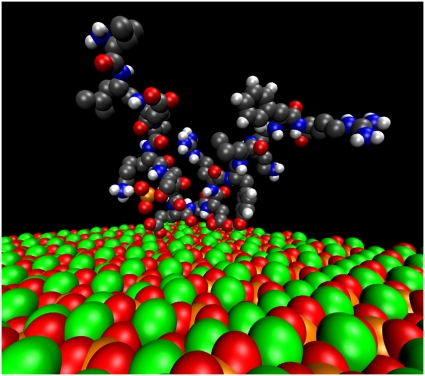
Molecular-dynamics analysis of peptide VLDPKpSKEDDRYLKFR adsorption to HA.Peptide is viewed at the end of the 5-ns simulation. Ca – green, O – red, P – orange, C – grey, H – white, N – blue.